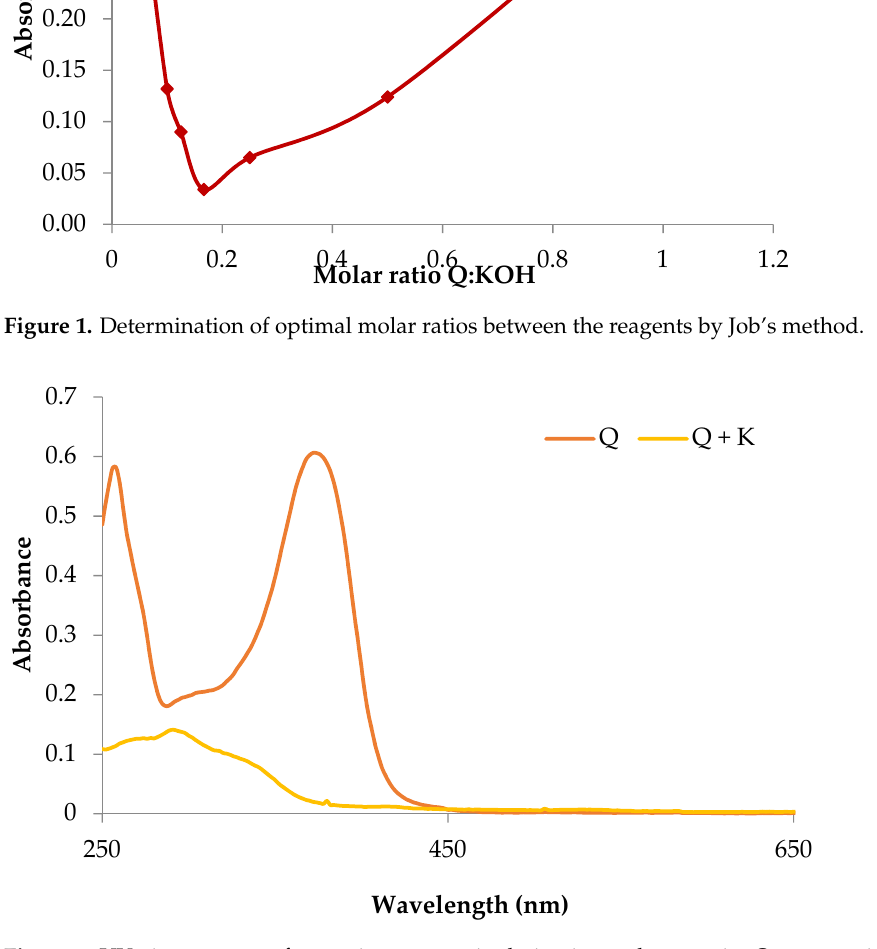
Figure 1. Determination of optimal molar ratios between the reagents by Job’s method.